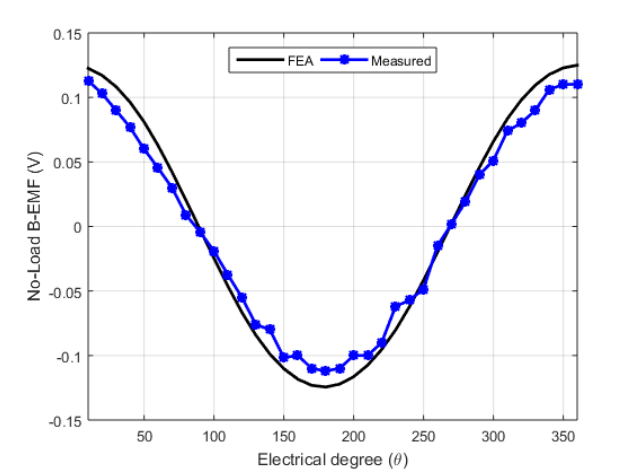
Figure 14. No-load induced B-EMF at 1.5 m/s.